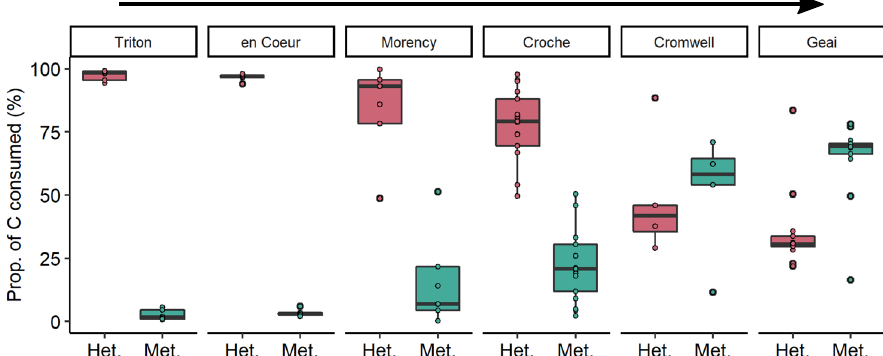
Fig. 3 Contribution of heterotrophy (Het., in rose) and methanotrophy (Met., in green) to the whole water column microbial carbon consumption (volume weighted rates) during summer in each studied lake. Each dot represents the fraction of C consumed by heterotrophy or methanotrophy calculated using a pro fi le taken at a different sampling date (Triton: n = 6, en Coeur: n = 5, Morency: n = 6, Croche: n = 16, Cromwell: n = 4, Geai: n = 13). Boxplots show median, fi rst and third quartiles (hinges), and 1.5 x interquartile range (whiskers). Lakes are plotted in order of increasing proportion of water column volume with CH 4 :O 2 molar ratio